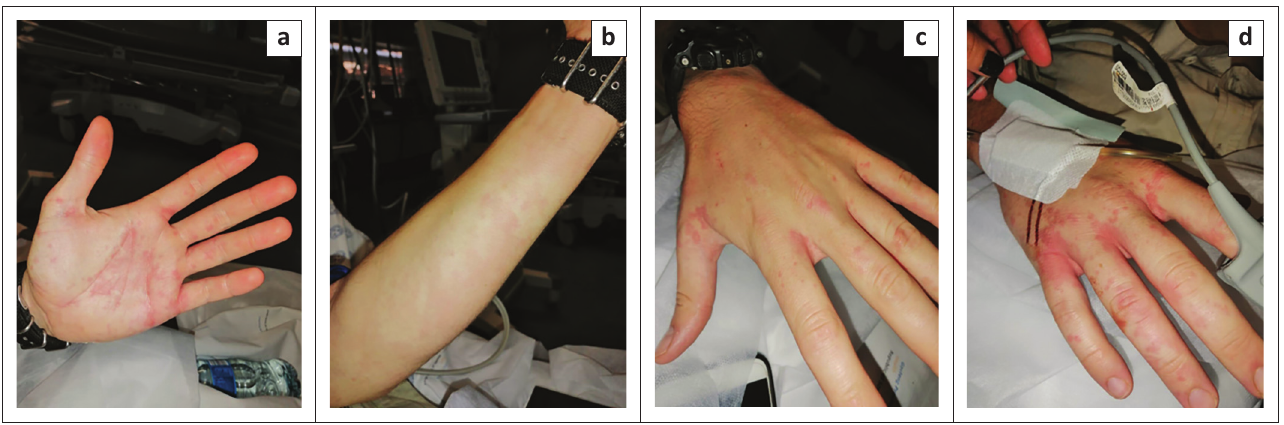
Source : Photos courtesy of patient. FIGURE 4: Allergic reaction after antivenom administration. (a–d) Uriticaria expression of allergic reaction.